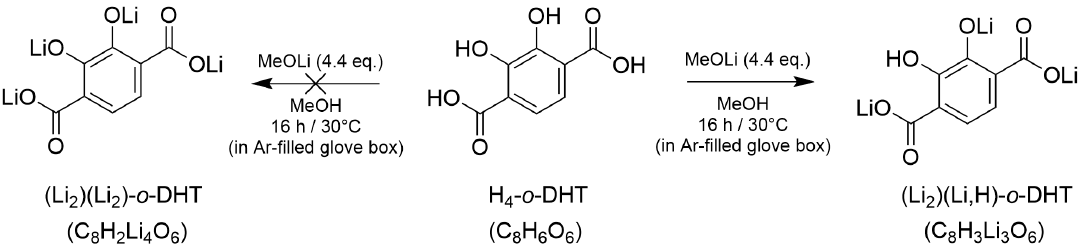
Scheme 1. Summary of the neutralization reaction of 2,3-dihydroxyterephthalic acid (H 4 - o -DHT) in presence of 4.4 equivalents of MeOLi in MeOH showing that a partial neutralization reaction